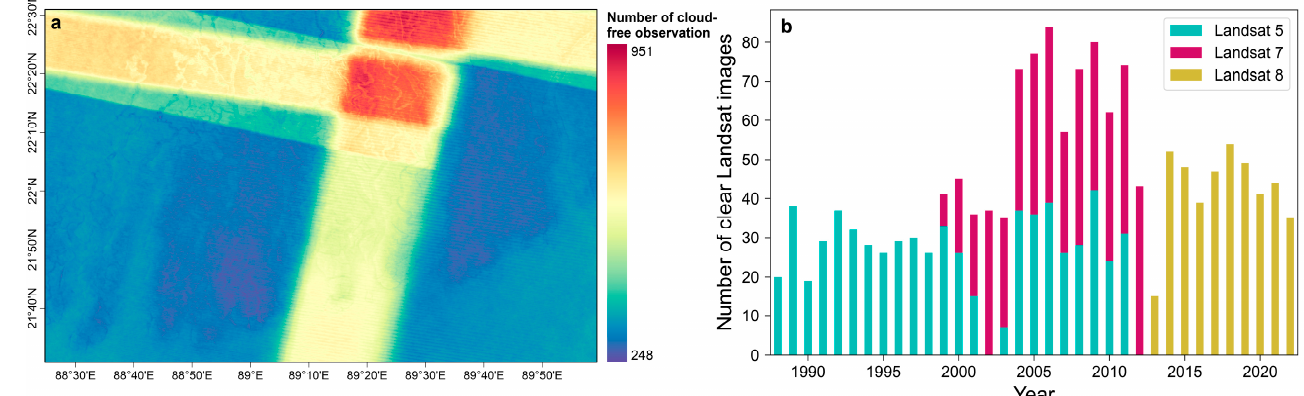
Figure 2. The number of good Landsat observations used to map mangrove change. ( a ) The spatial distribution of total cloud-free Landsat observations from 1988–2022, which provides pixel-level details of how many Landsat observations were available for classification. ( b ) Numbers of clear images (cloud coverage < 30%) by Landsat sensors for each year.